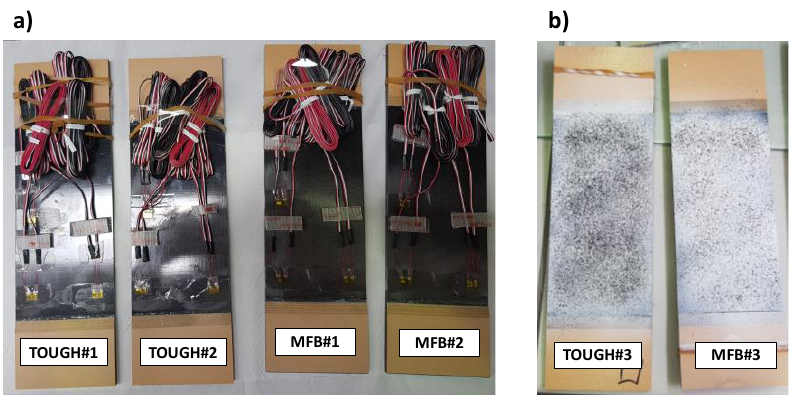
Figure 5. Samples preparation for strain monitoring ( a ) and DIC ( b ).